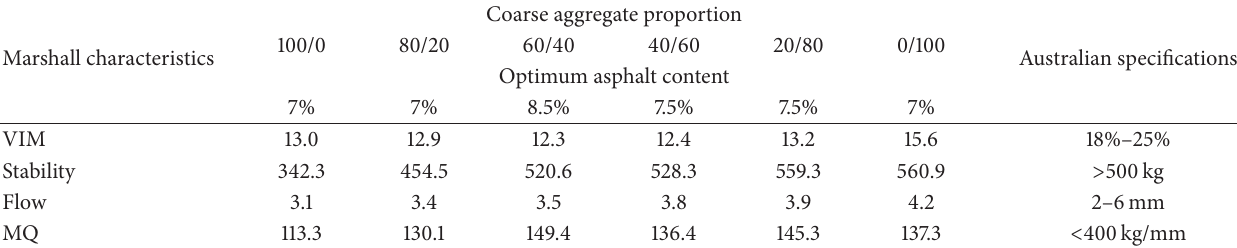
Table 9: Summary of optimum asphalt content and its Marshall characteristics.